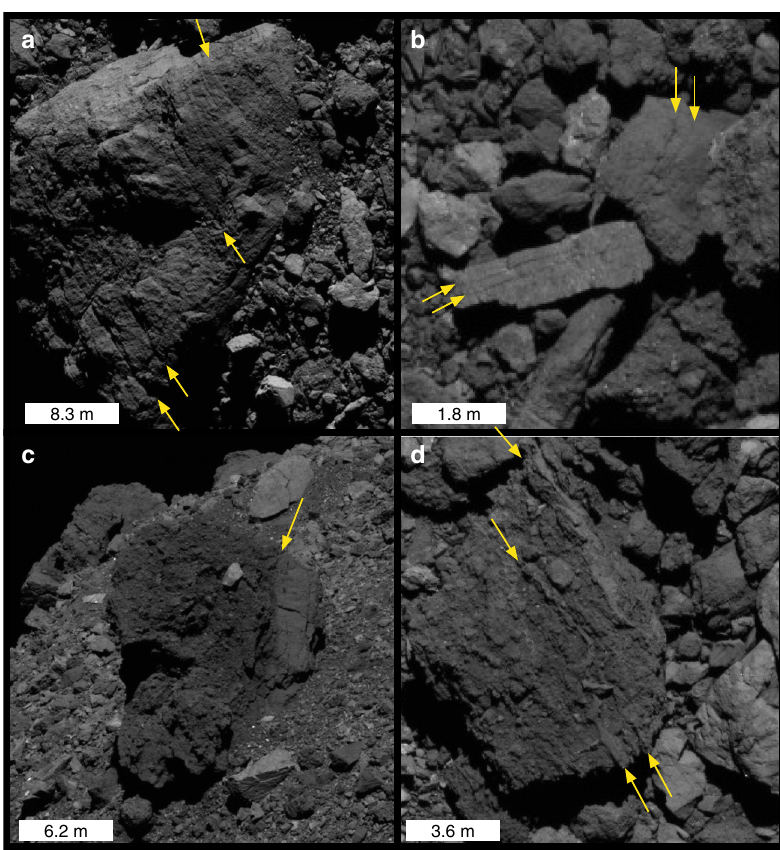
Fig. 3 Boulder textures on Bennu. Examples of ( a – d ) textures and fabrics observed in boulders of varying size.